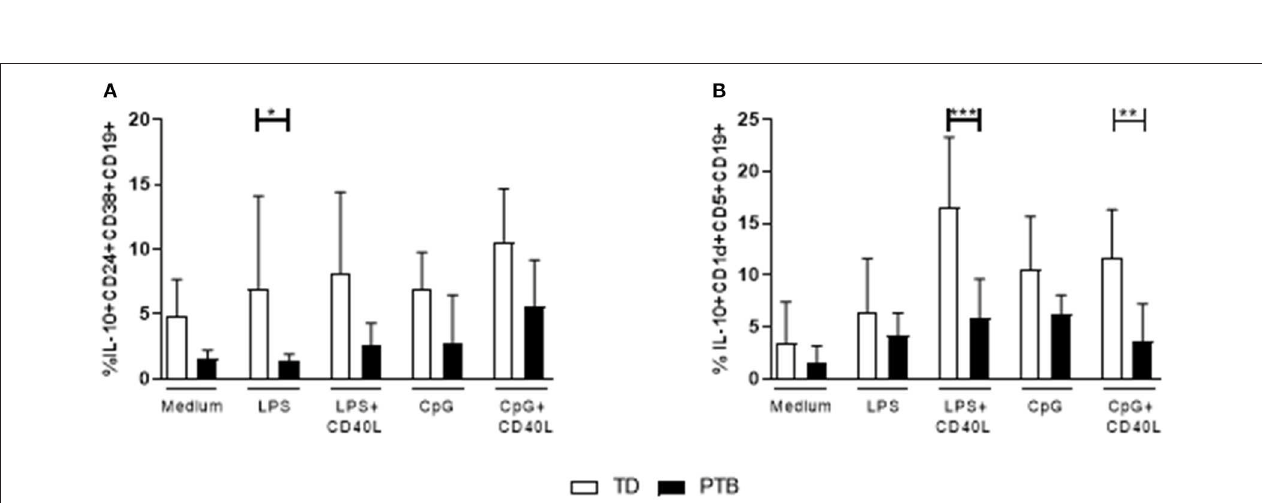
FIGURE 3 | Regulatory B cell populations in maternal blood before delivery. The frequency of IL-10-producing CD38 hi CD24 hi CD19 + (A) and CD1d hi CD5 + CD19 + Breg cells (B) was determined following stimulation of PBMCs with LPS or CpG alone or combined with CD40L for 48h. For the last 5h, Brefeldin A PMA and ionomycin was added to the cultures. Breg cells were detected by flow cytometry. Data were analyzed using two-way ANOVA with Sidak’s multiple comparisons test. Shown is the mean and SD. TD, term delivery; PTB, preterm birth; * p < 0.05; ** p < 0.005; *** p < 0.001.